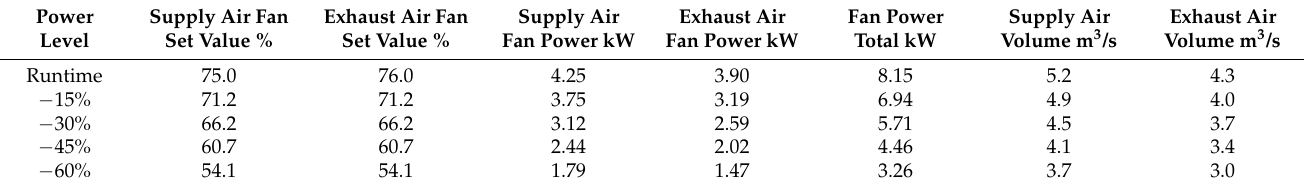
Table 3. The power curve test results. All runtime values (the first row) were observed from the BMS running in automatic mode. Next the BMS was switched to manual mode and such fan speed set values were experimented that resulted in the intended reduction in total fan power while preserving the supply and exhaust air volume